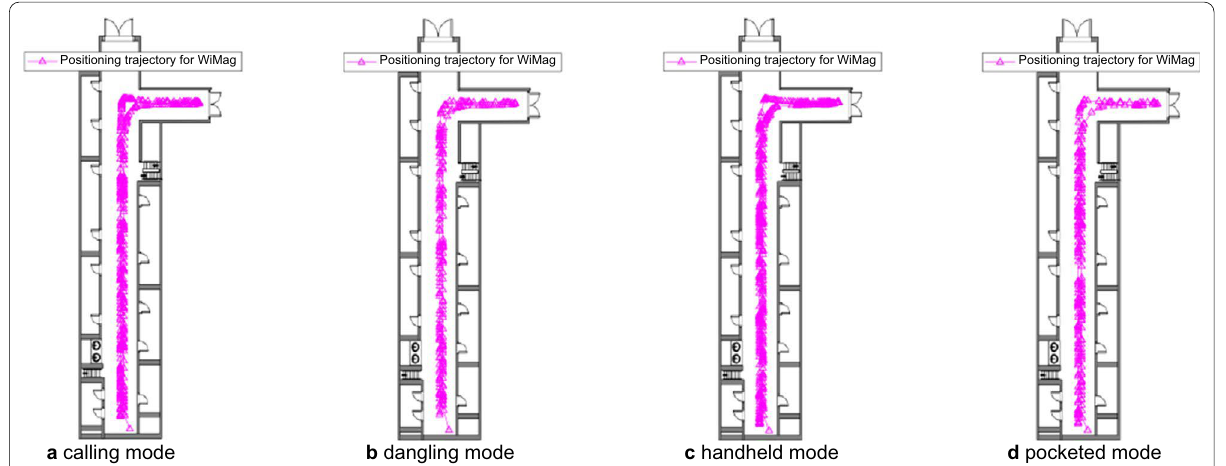
Fig. 18 Positioning trajectories with different modes for WiMag